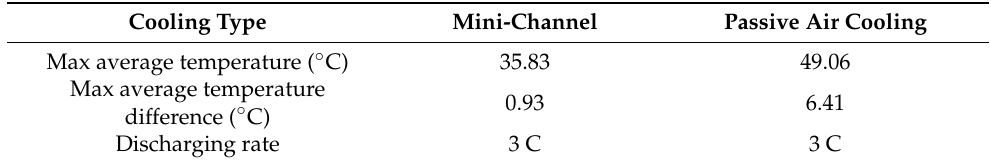
Table 6. Comparison with passive air